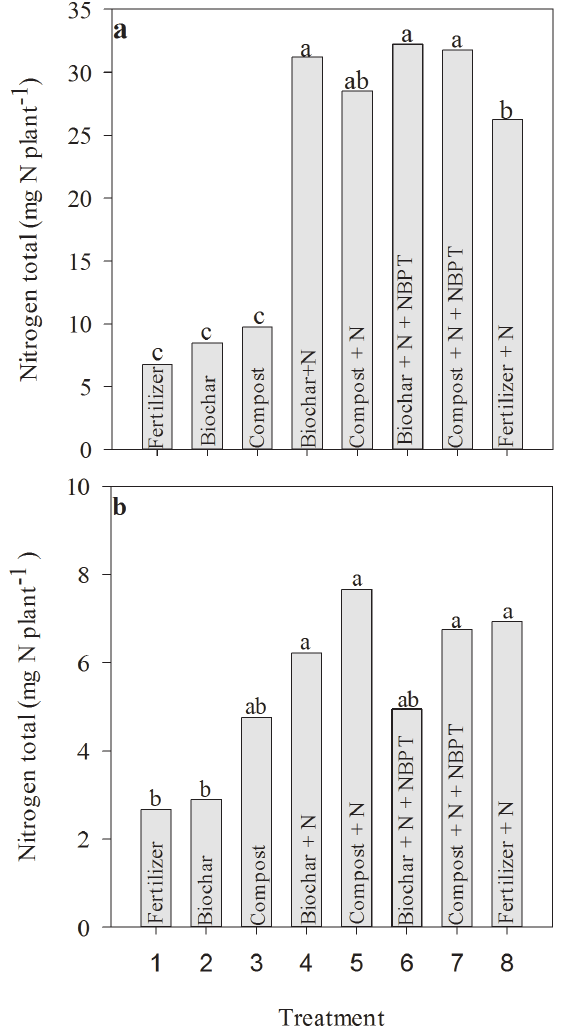
Figure 2 - Total N assimilation per plant in shoots ( a ) and roots ( b ) in response to the addition of compost and biochar combined with N and urease inhibitor: 1- Fertilizer; 2- Biochar; 3- Compost; 4- Biochar + N; 5- Compost + N; 6-Biochar + N + NBPT; 7- Compost + N + NBPT; and 8- Fertilizer + N. Treatments followed by similar letters do not differ by Tukey’s test at the 5% significance